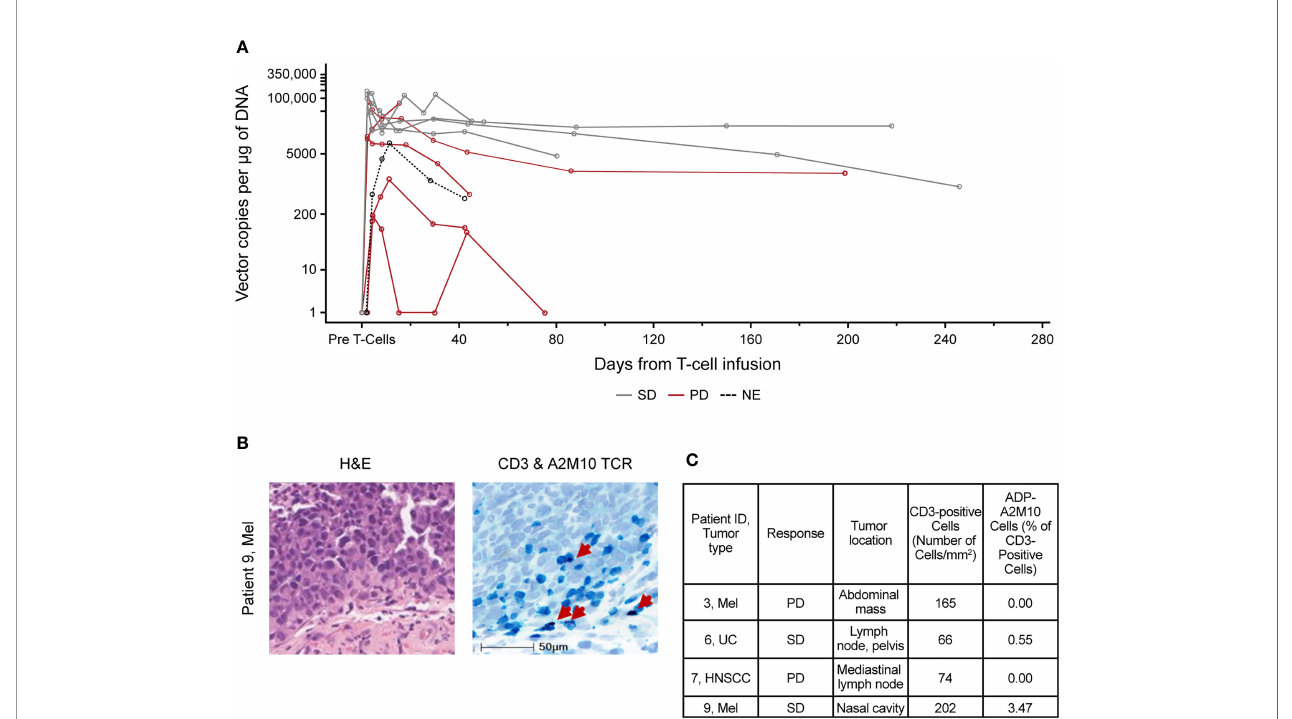
FIGURE 2 | ADP-A2M10 were detected in peripheral blood and tumor tissue after infusion. (A) Persistence of ADP-A2M10 was measured by quantitative PCR of the Psi element sequence in genomic DNA extracted from peripheral blood mononuclear cells. Data points are colored by response. (B) Representative fi elds for detection of CD3+ and/or ADP-A2M10 TCR+ cells by CD3 immunohistochemical/RNA in situ hybridization assay in tumor tissue of patient 9 collected within 12 weeks after infusion. In the right image, CD3+ cells are shown in teal, ADP-A2M10 TCR+ cells are shown in purple, and nuclei are shown in light blue (hematoxylin stain). (C) Result table for CD3 immunohistochemical/RNA in situ hybridization duplex assays reporting the detection of ADP-A2M10 in two of four post-infusion tumor samples collected from the study patients. H&E, hematoxylin and eosin stain; HNSCC, head and neck squamous cell carcinoma; Mel, melanoma; NE, not evaluable; PD, progressive disease; SD, stable disease; TCR, T-cell receptor; UC, urothelial